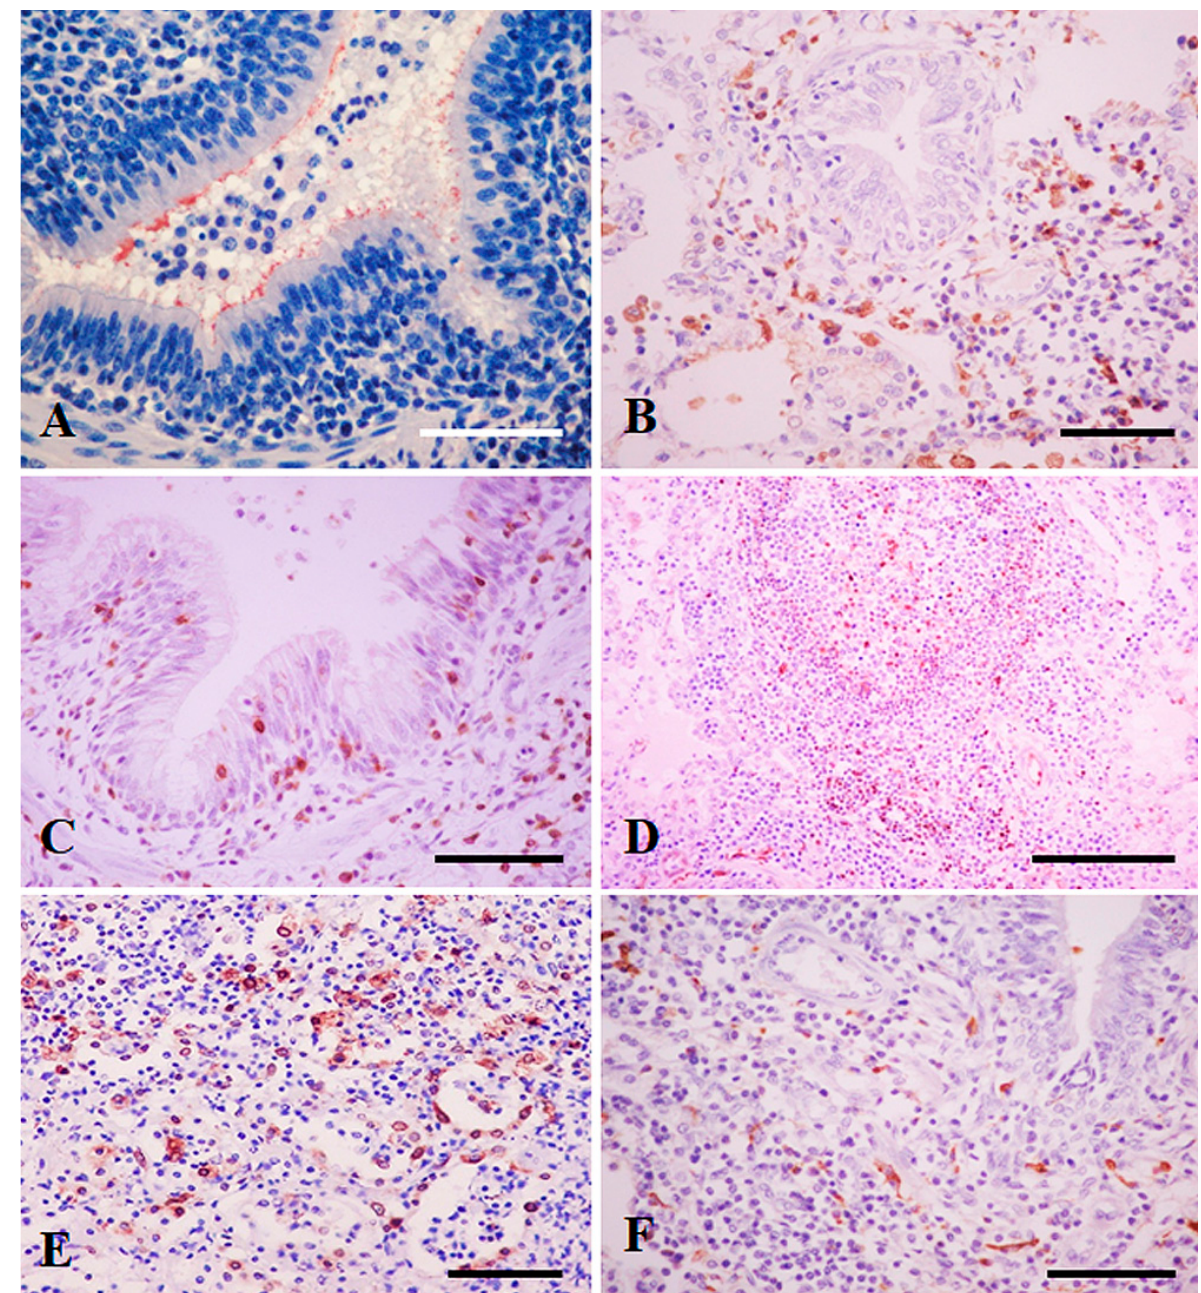
Figure 1. ( A ) Immunolabelling of Mhy-antigen on the surface of bronchial epithelial cells, pig n° 19. ( B ) Infiltration of macrophages and lymphocytes in alveolar spaces labelled for IL-12, pig n° 12. ( C ) Intraepithelial and peribronchiolar lymphocytes immunostained with IL-10 antibody, pig n° 11. ( D ) IL-2 reaction in lymphocytes of the BALT, pig n° 15. ( E ) IL-8 immunoreaction in alveolar exudate and pneumocytes, pig n° 23. ( F ) Cells with dendritic processes immunolabelled with INF- γ antibody, pig n° 14. Bars = 150 μ m.